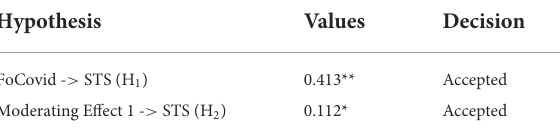
TABLE 3 Structural model/ Hypothesis testing